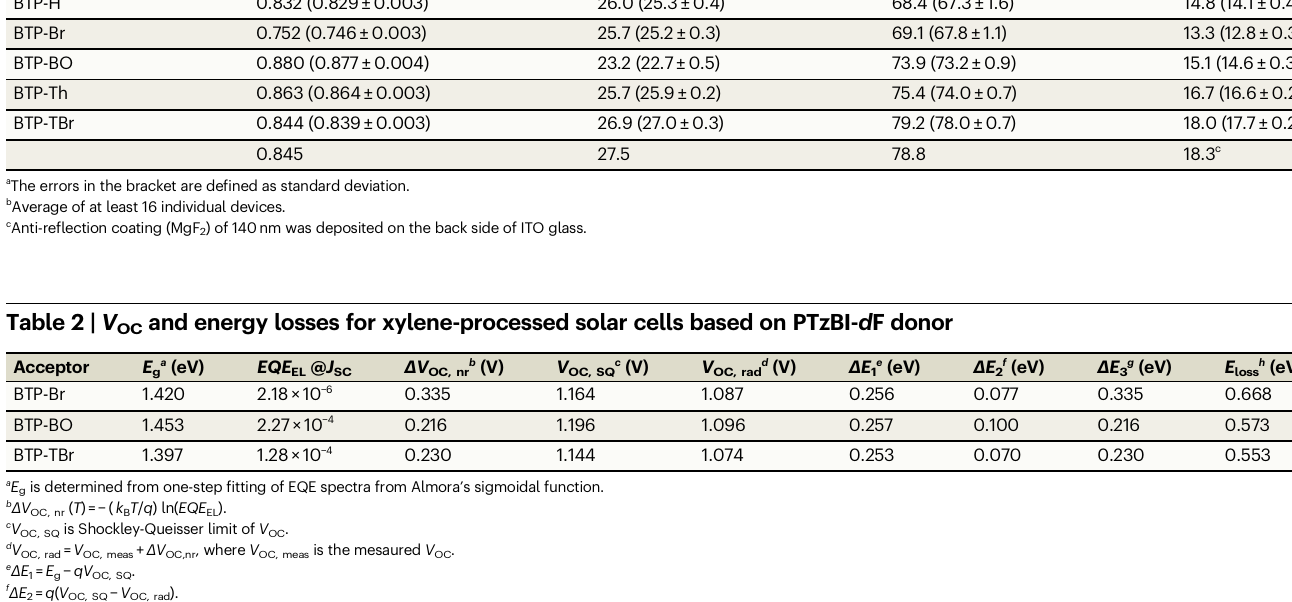
Table 1 | Photovoltaic parameters for xylene-processed solar cells based on polymer donor PTzBI- d F and various acceptors Acceptor